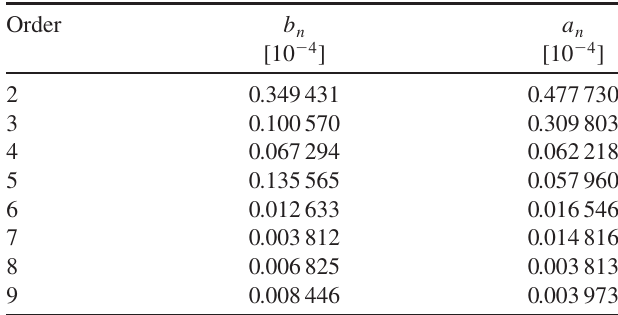
TABLE I. Random part of the relative magnetic errors of the low-beta quadrupoles at 17 mm radius [24]. The components b n and a n stand for normal and skew multipolar errors, respectively.